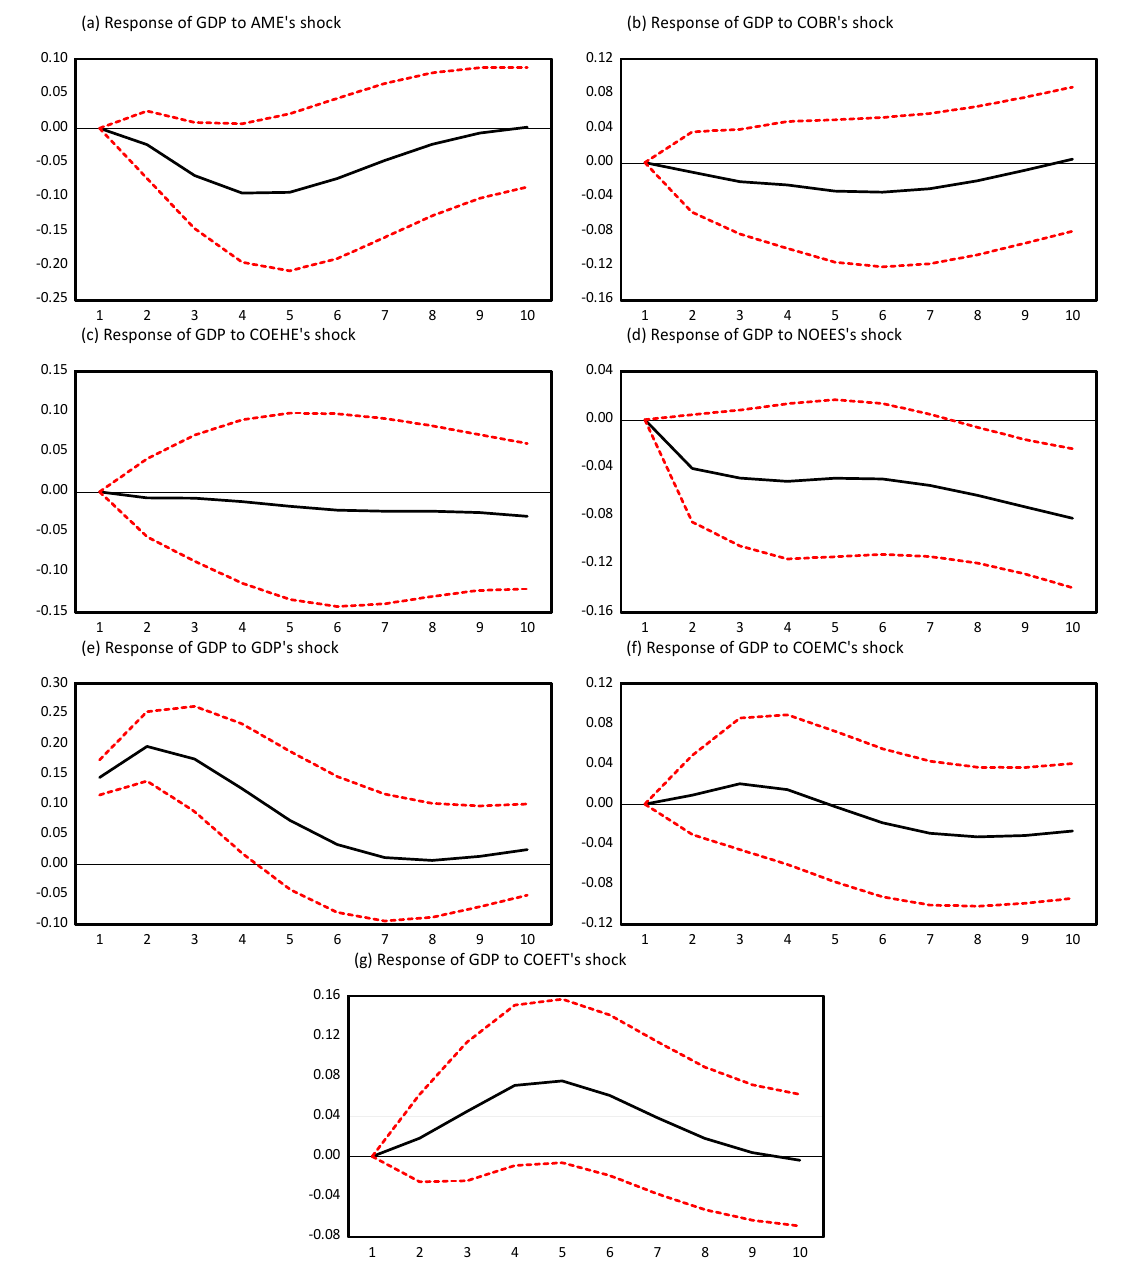
Figure 3. Impulse response functions.